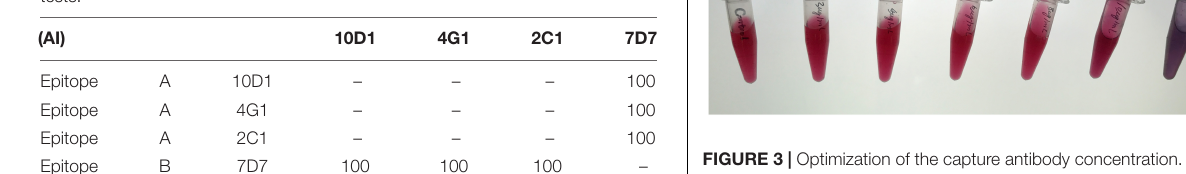
FIGURE 3 | Optimization of the capture antibody concentration. Serial dilutions of purified capture antibody 7D7 were prepared containing 3, 4, 6, 8, 10, 12, and 14 µ g/ml (B–H) and mixed with colloidal gold solution; colloidal gold solution alone served as a control (A) .